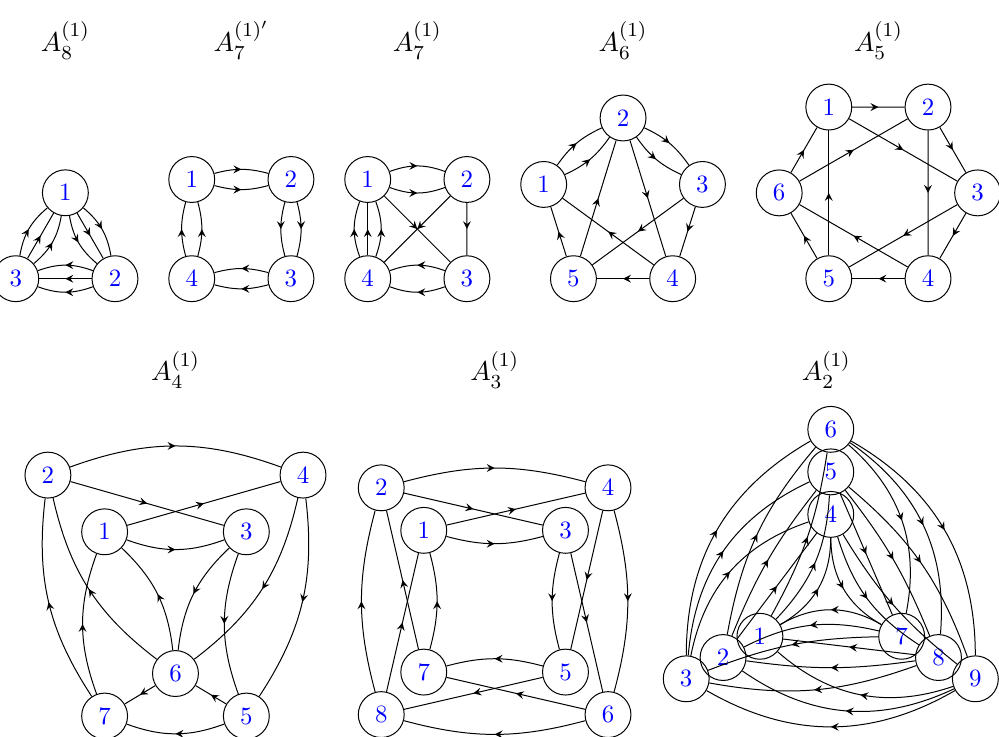
Figure 2 . Quivers corresponding to polygons with one interior